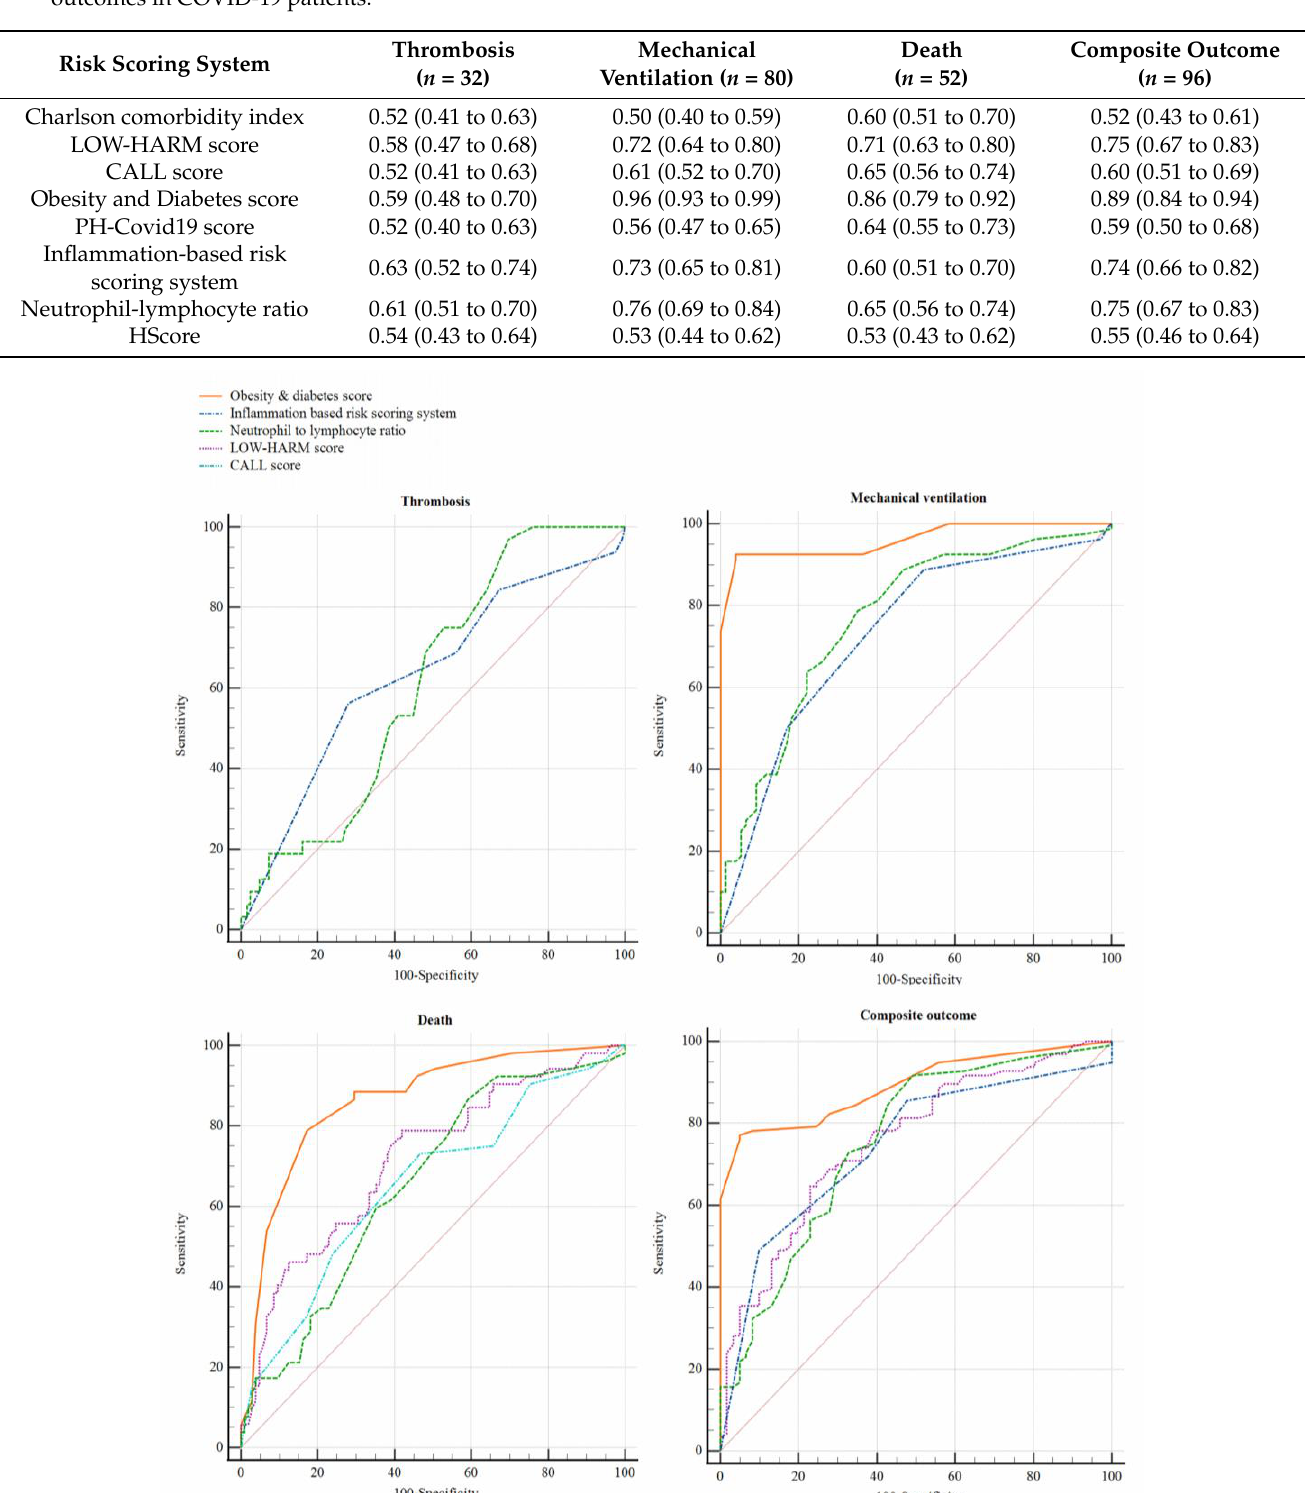
Table 3. The area under the receiver operating characteristic curve (AUC-ROC) of each risk scoring system to predict major outcomes in COVID-19 patients.